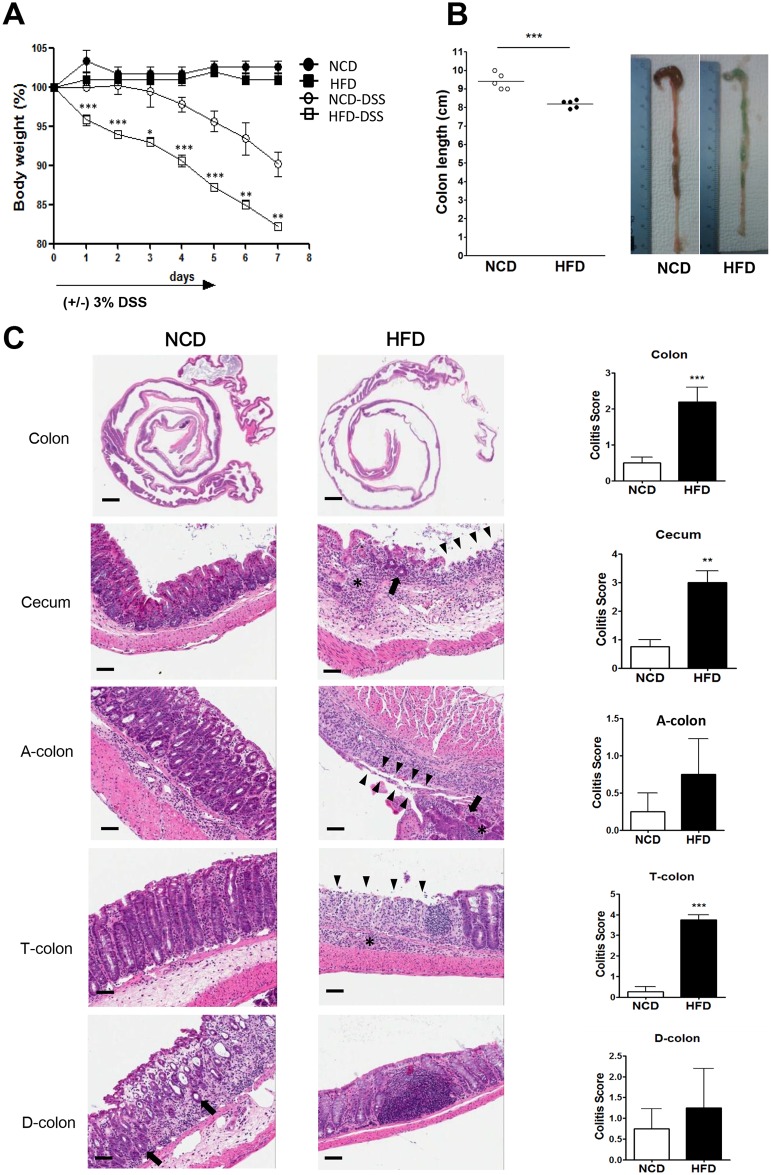
Aggravated experimental colitis in high-fat diet (HFD)-fed mice.(A) Mice fed normal chow diet (NCD) or HFD for 15 weeks were either untreated or treated with 3% dextran sodium sulfate (DSS) for 5 days, and monitored for colitis progression. Body weight is presented as the percentage of the initial weight. (B) Colon lengths measured on day 7 of DSS administration (left). Representative images of the colon are shown (right). (C) Representative H&E sections of the cecum, the ascending colon (A-), transverse colon (T-), and descending (D-) colon on day 7 of DSS administration to NCD-fed (left column) or HFD-fed (middle column) mice (arrowheads, ulceration; asterisks, inflammation; arrows, regeneration of crypts). Colitis scoring on day 7 of DSS administration (right column). Original magnification for all images is ×100, except the top row of (C) (×10). Scale bar, 100 μm. All values are expressed as the means ± SEM. A student’s t-test was used to compare values between two groups. *P < 0.05, **P < 0.01, ***P < 0.001 (n = 5 each).